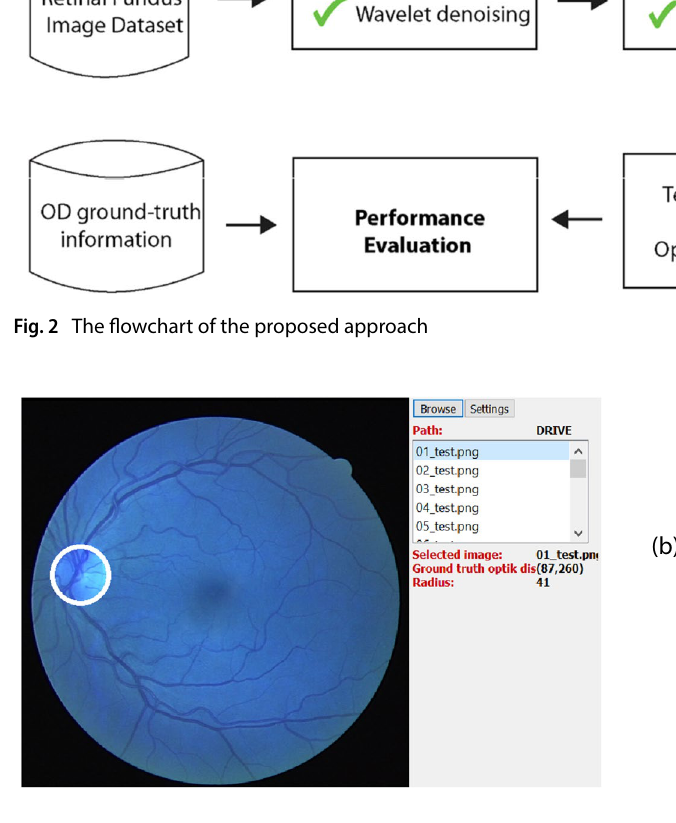
Fig. 3 The determination of ground-truth and radius information for an optic